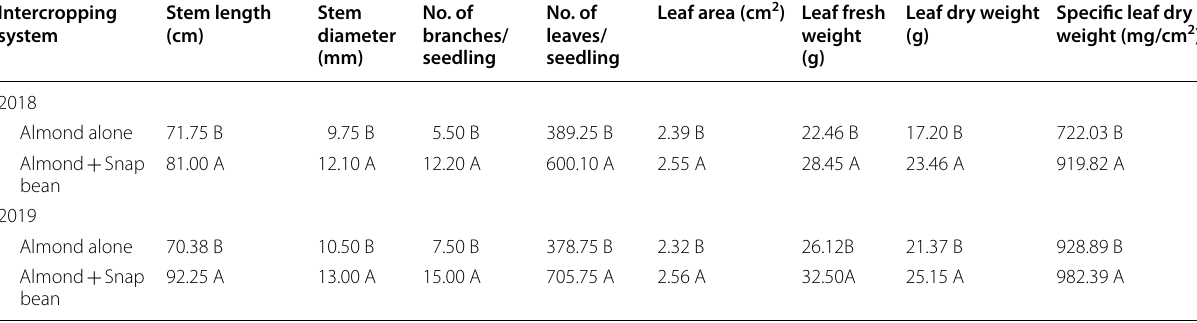
Values with diferent letter across the same row are signifcantly diferent ( p < 0.05)